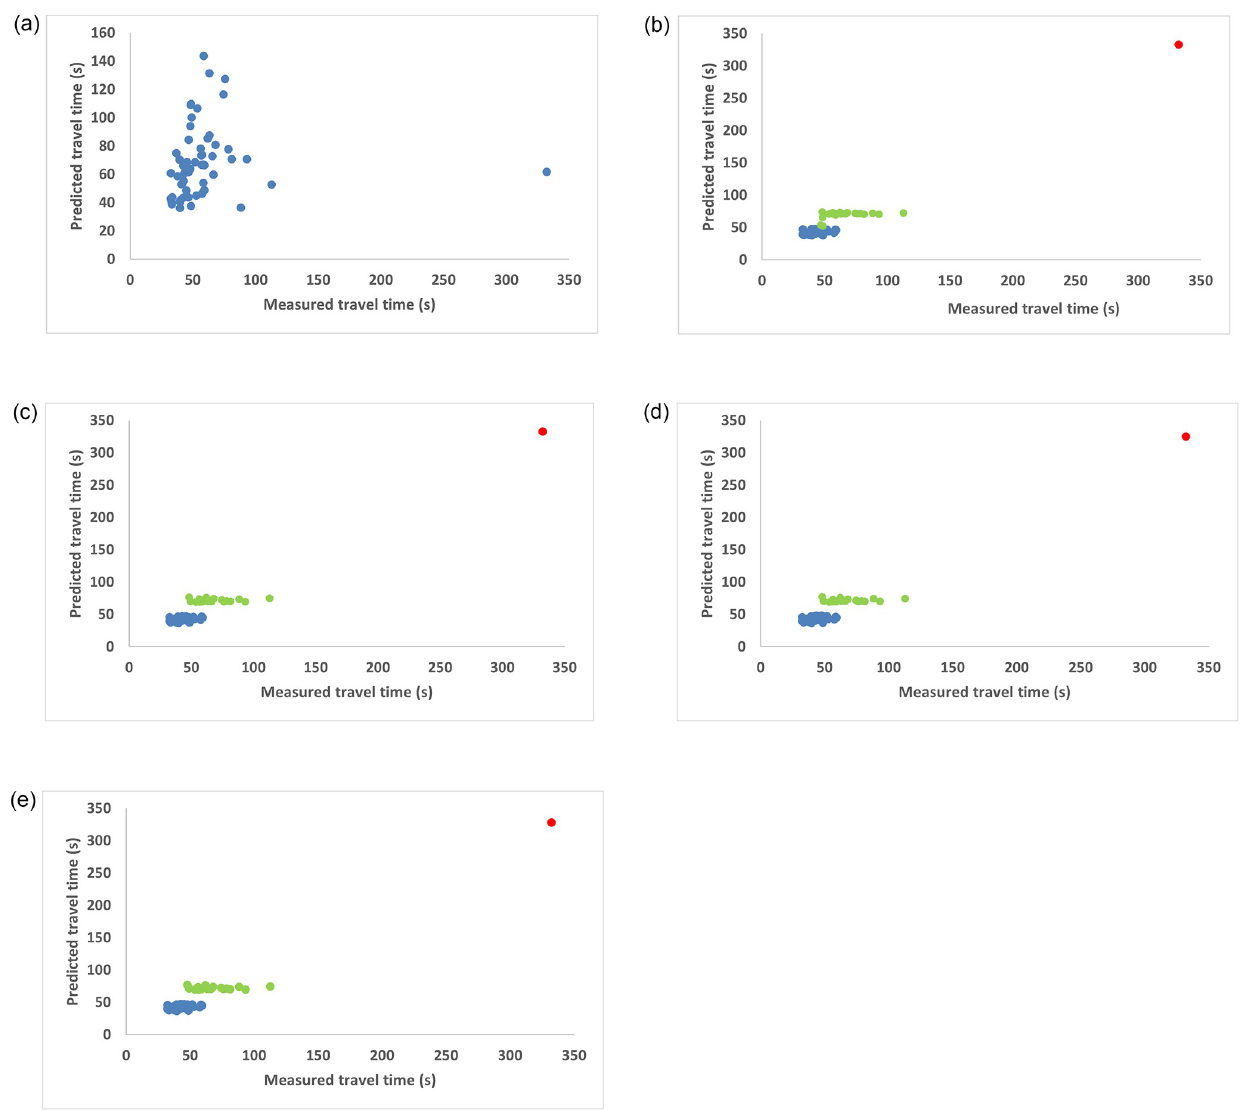
Fig 3. Measured vs predicted travel times over iterations. (a) Iteration 0, (b) Iteration 1, (c) Iteration 2, (d) Iteration 3, (e) Iteration 4.